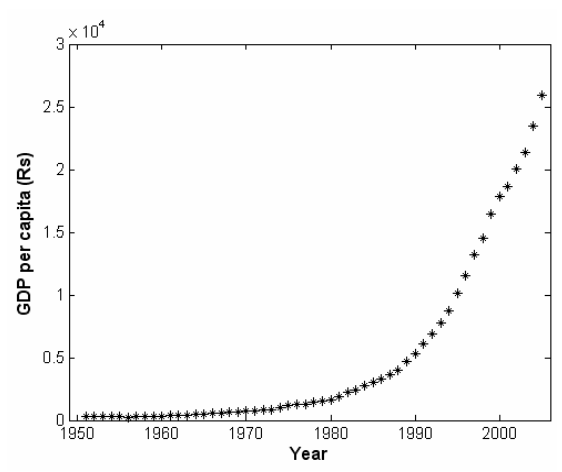
Fig 7. Variation of yearly GDP per capita